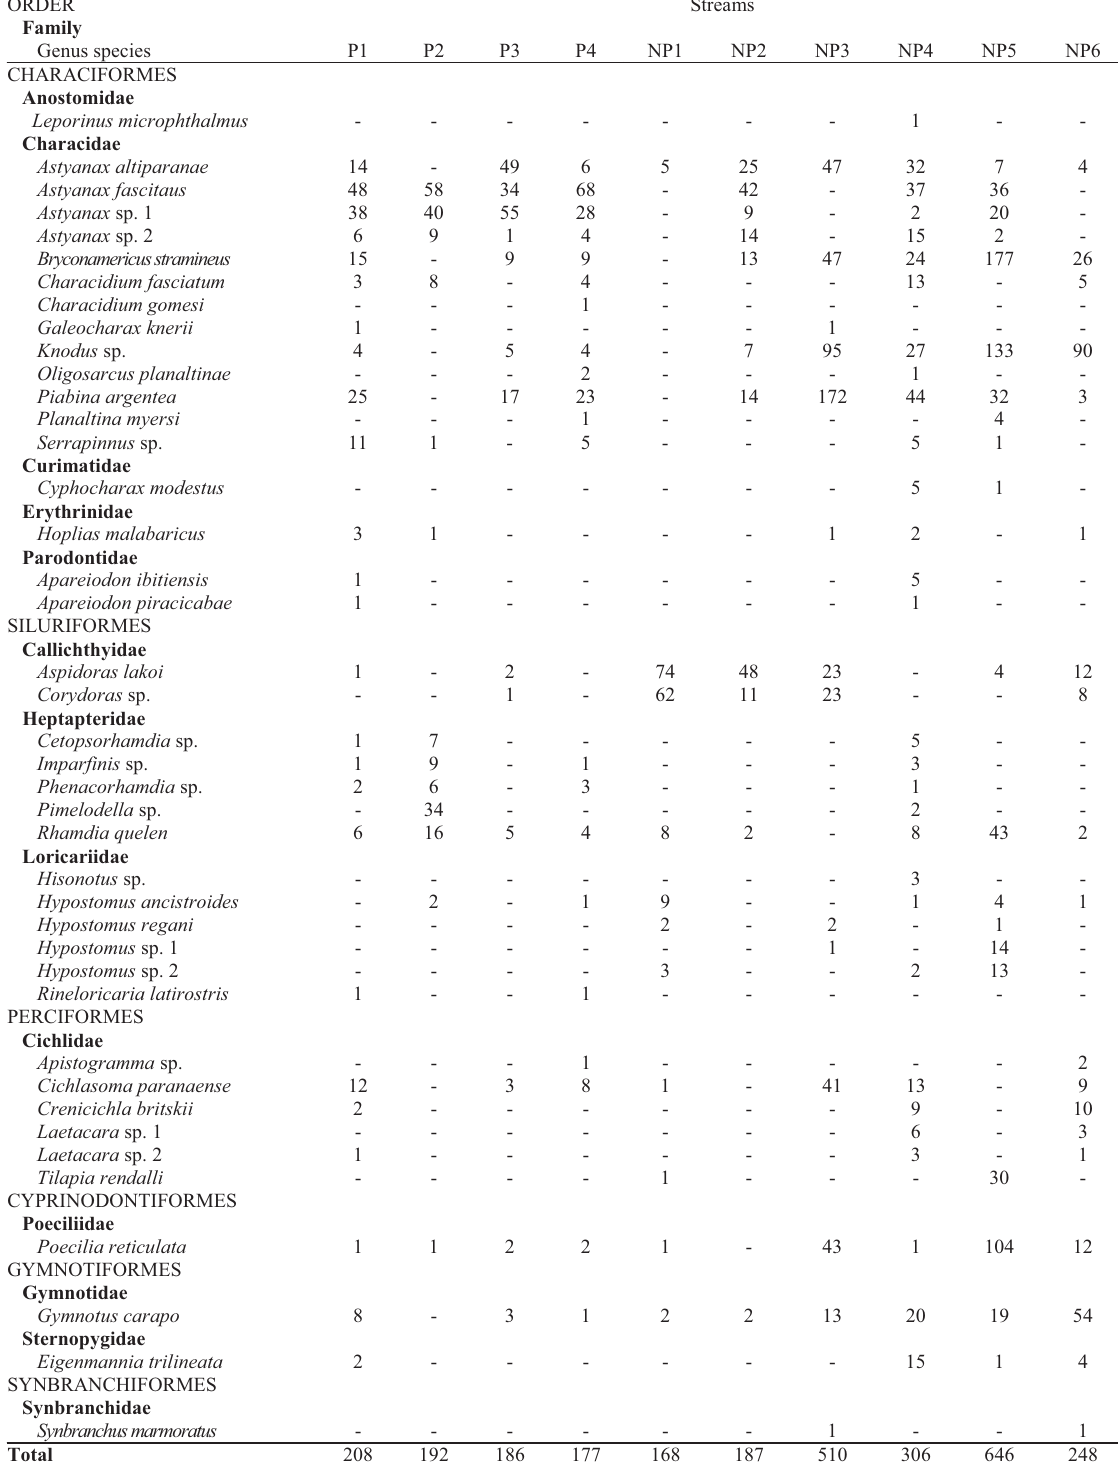
Table 2. Number of fish per species collected in the streams located in preserved (P) and impacted (NP) areas in the João Leite River